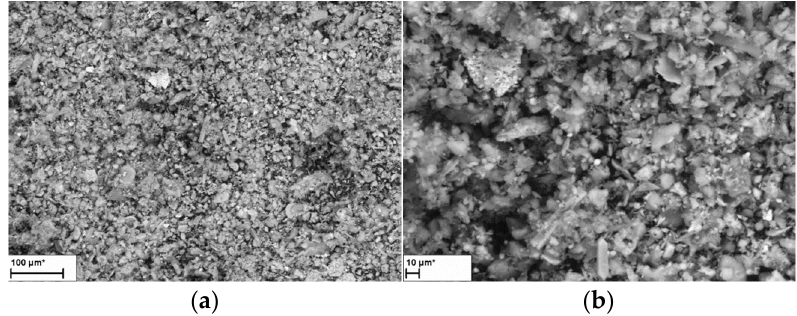
Figure 1. Fly ash microstructure in magnification: ( a ) 400×; ( b ) 1000×. The TGA-DTA thermal analysis was also conducted for the fly ash used in the re- search (Figure 2).